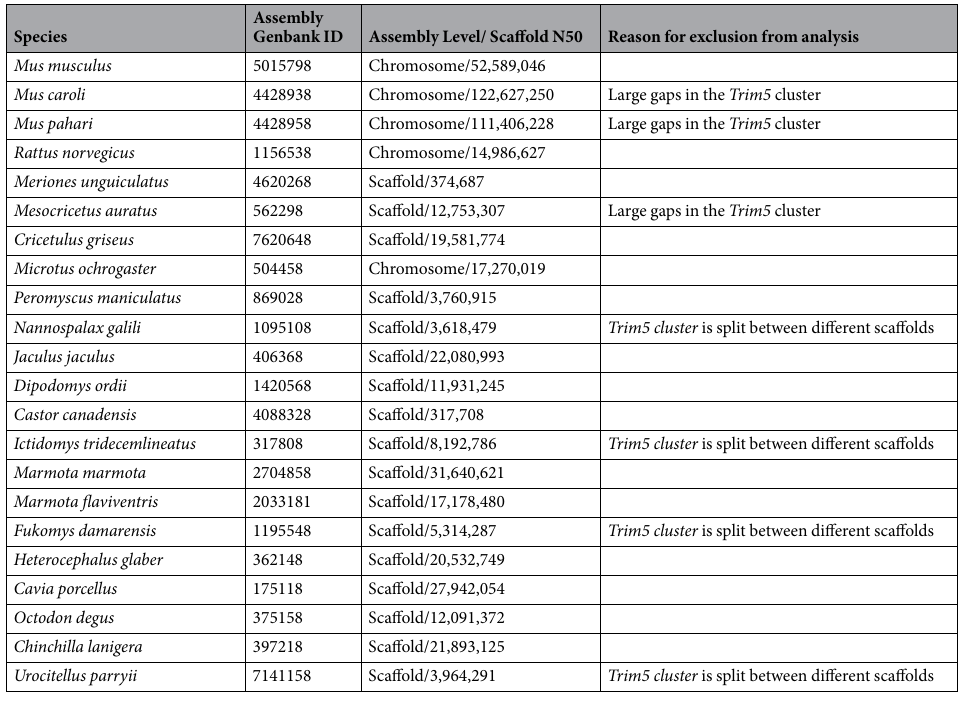
Table 1. Genome assemblies analyzed for Trim5